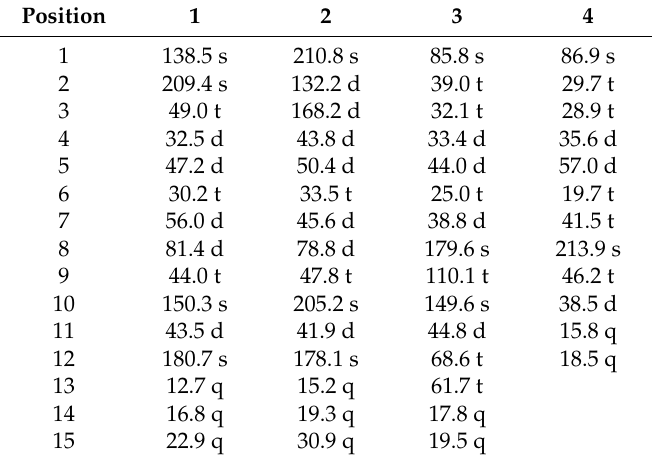
Table 2. 13 C-NMR spectroscopic data for compounds 1 – 4 a